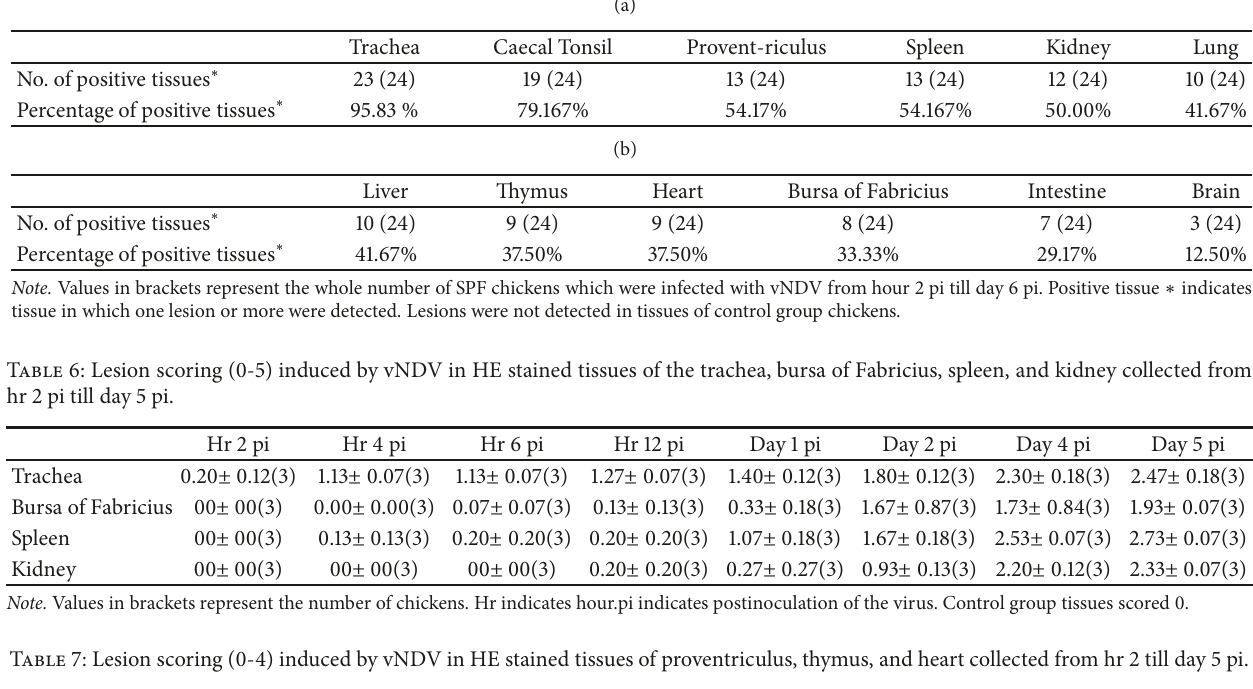
Table 5: Numbers and percentages of different vNDV-infected tissues stained with HE in which lesions appeared from hr 2 pi till day 6 pi.